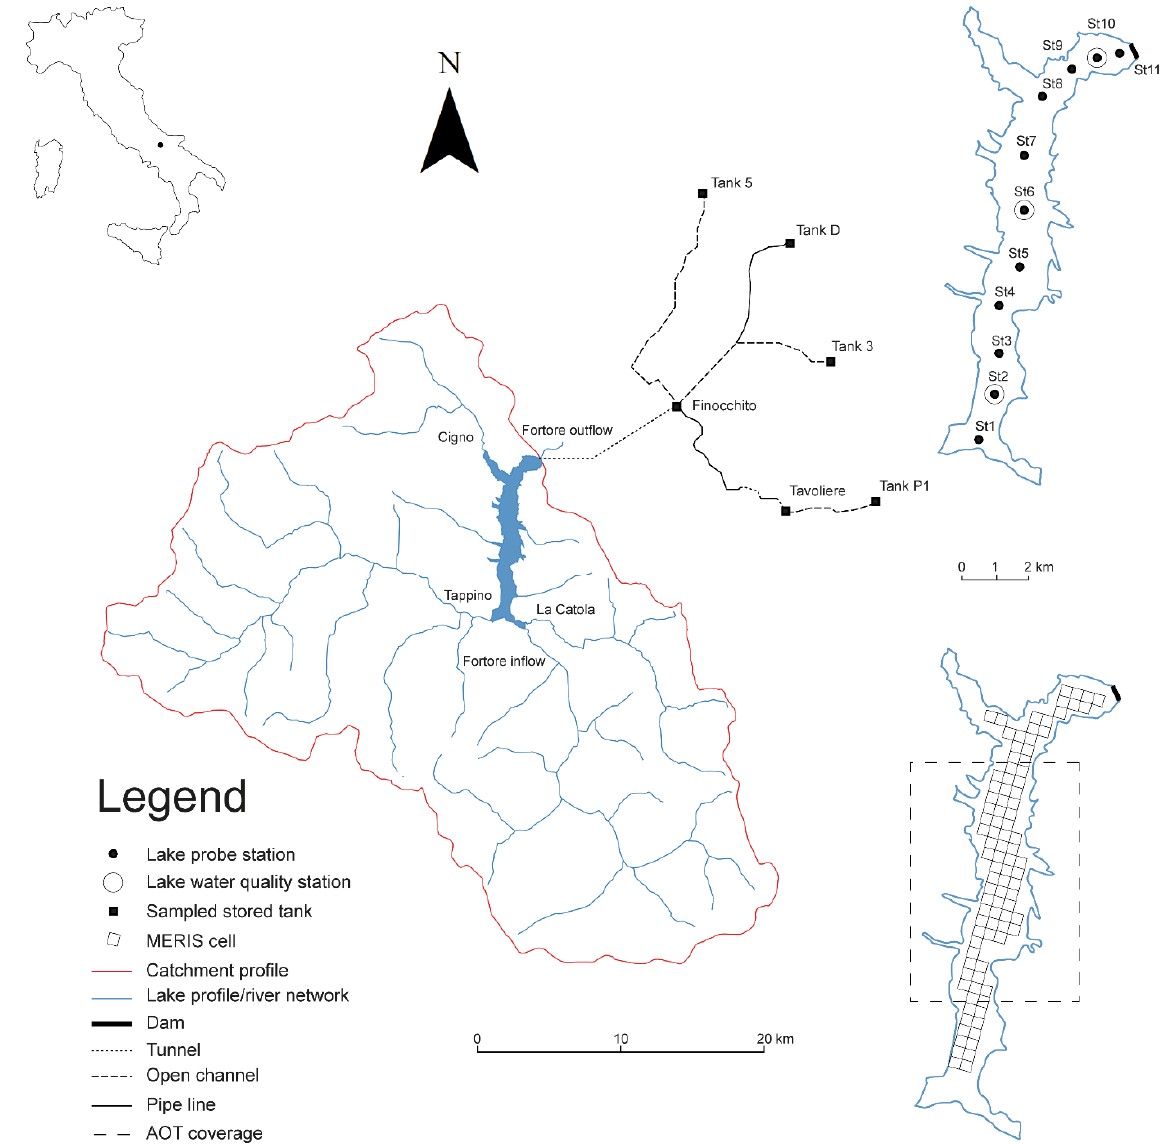
Figure 1. Top left : Lake Occhito position in the Italian peninsula. Main panel : Lake Occhito profile within its catchment and a schematic of the main rivers and of the irrigation network, including the storage tanks sampled in this study. Top right : Lake Occhito profile with indication of the in-situ sampling stations. Bottom right : Lake Occhito profile containing the MERIS (Medium Resolution Imaging Spectrometer) cell coverage used in this study. The dashed line delimits the area where the MOD09 AOT (Aerosol Optical Thickness) values were averaged to be used for the atmospheric corrections of MERIS data.